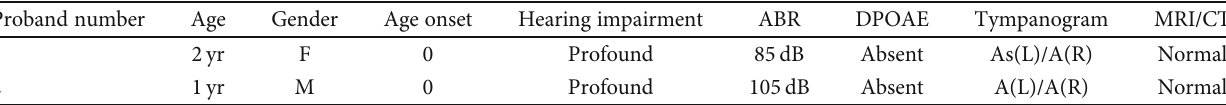
Table 1: The clinical information of the patients.